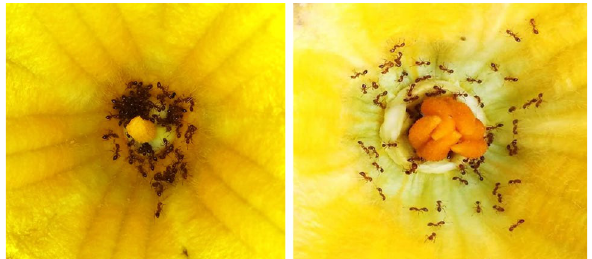
Figure 1. A staminate (male) and a pistillate (female) flower of pumpkin ( Cucurbita maxima ) occupied by the of ants occupied a single flower. Whenever the ant colony was too large in number, the flowers were cut open to facilitate counting the ant individuals.